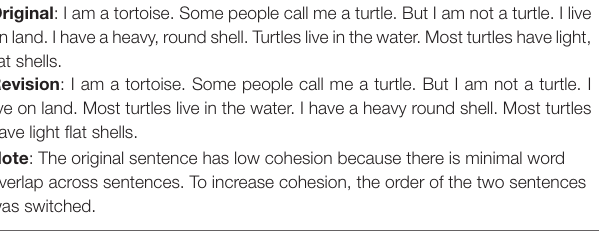
TABLE 4 | Example of sentences with low cohesion and proposed modifications.